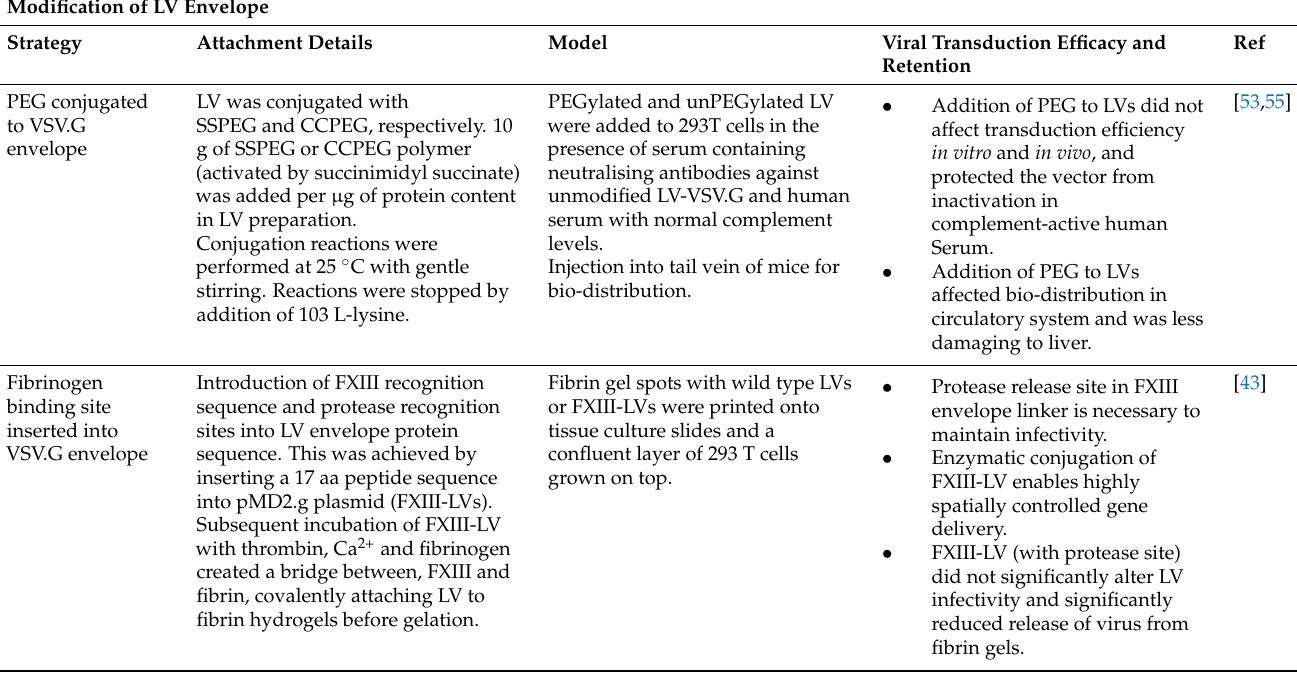
Table 4. Studies that have modified the LV envelope with a biomaterial, or to improve attachment of LV to a biomaterial. aa; amino acid, VSV.G; Vesicular stomatitis virus G PEG; Polyethylene (glycol), CCPEG; cyanuric chloride monomethoxy polyethylene glycol, SSPEG; suc- cinimidyl succinate monomethoxy polyethylene glycol, FXIII; Transglutaminase Factor